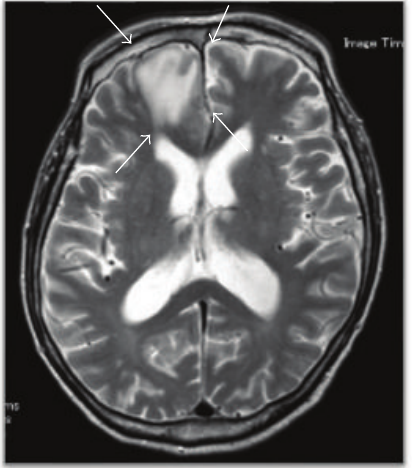
Figure 5: MR images (T2WI) showing hypointensity lesion in the right frontal lobe.